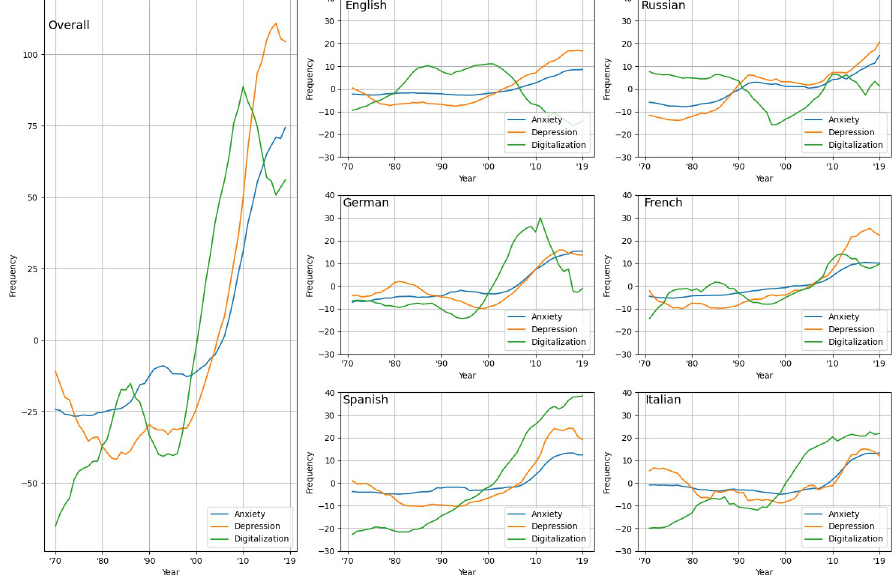
Fig 1. List-averaged word frequencies from 1970 until 2019 for each category and language. Frequencies (in percent) are z-transformed, most common word controlled, and summed over all words.